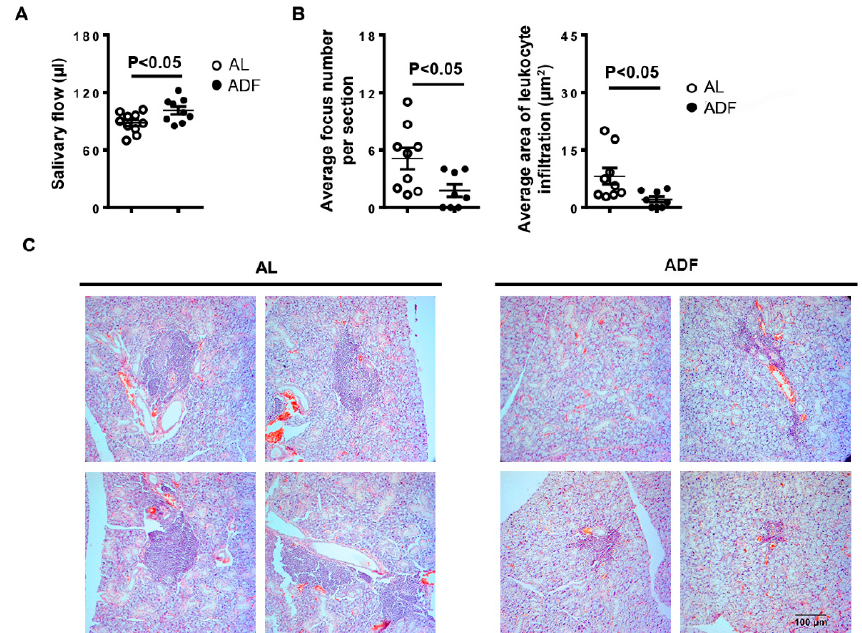
Figure 1. Alternate-day fasting (ADF) improves SS-associated hyposalivation and mitigates salivary gland inflammation in NOD mice. 10-week-old female NOD mice were deprived of food every other day or fed with standard chow ad libitum ( AL ) for 3 weeks. ( A ) The stimulated salivary flow rate. ( B ) The graph shows the average leukocyte focus number and infiltration areas of SMG sections. ( C ) Tile mages of H&E stained areas of one representative SMG sample each treatment group (scale bar = 100 µm). Data are representative or the average of 9–10 mice from each group.